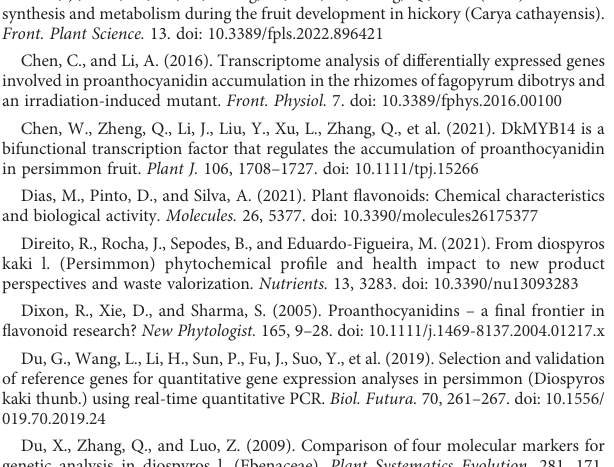
SUPPLEMENTARY FIGURE 3 WGCNA analysis. (A) Soft threshold selection; (B) Module hierarchical clustering tree; (C) The gene co-expression module; (D) The correlation between samples and modules; (E) Gene expression pattern of the MEblue module; and (F) KEGG enrichment analysis of the MEblue